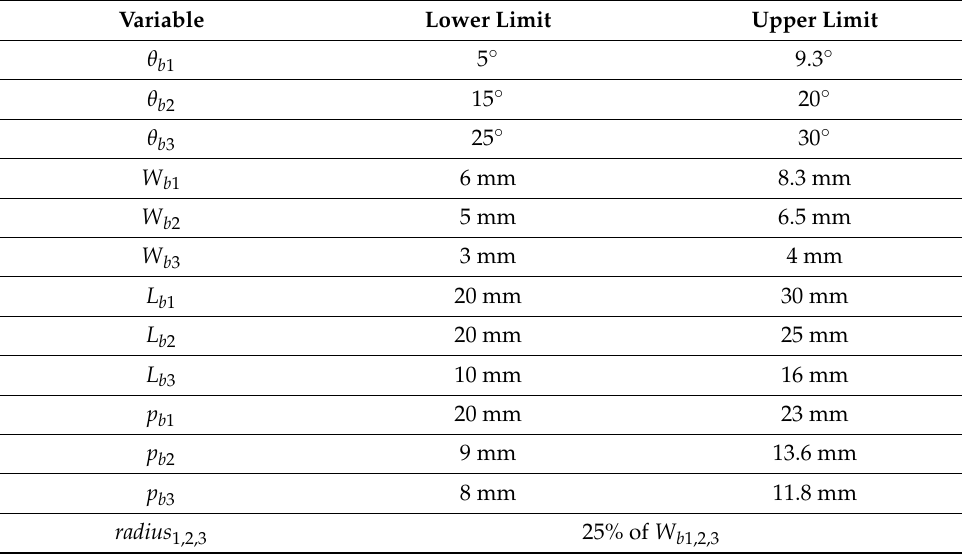
Table 2. Rotor variables upper and lower limits.